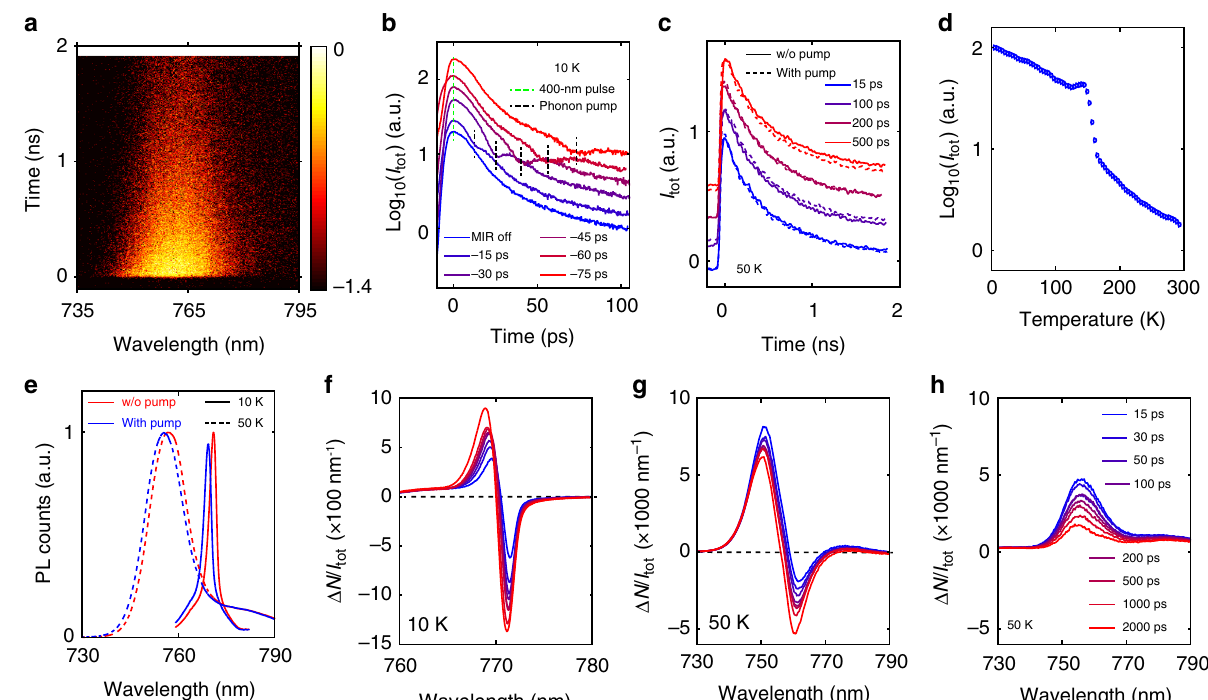
Fig. 4 Infrared pump photoluminescence (PL)-probe measurements of CH 3 NH 3 PbI 3 . a Spectrally and temporally resolved PL counts measured with a streak camera (scalebar is in log 10 scale) without using the infrared pump. b Decay kinetics of the PL intensity acquired under various negative Δ t values. c Decay kinetics of the PL intensity acquired under various positive Δ t values, with (dashed lines) and without (solid lines) using the infrared pump. d Static, temperature-dependent, wavelength-integrated PL intensity of the CH 3 NH 3 PbI 3 fi lm. e Time-integrated PL spectra acquired at 10 K and at 50 K, with Δ t = 2000ps. Relative change of the time-integrated PL spectra with various positive delay times measured at 10 K in ( f ), and measured at 50 K in ( g , h ). An on-resonance (3120 cm − 1 ) infrared pump was used in ( e , f , g ); an off-resonance (2200 cm − 1 ) infrared pump was used in ( h ). Fluence of the infrared pump was fi xed at 3.8 mJ cm − 2 in these measurements. Legend in ( h ) also applies to ( f , g